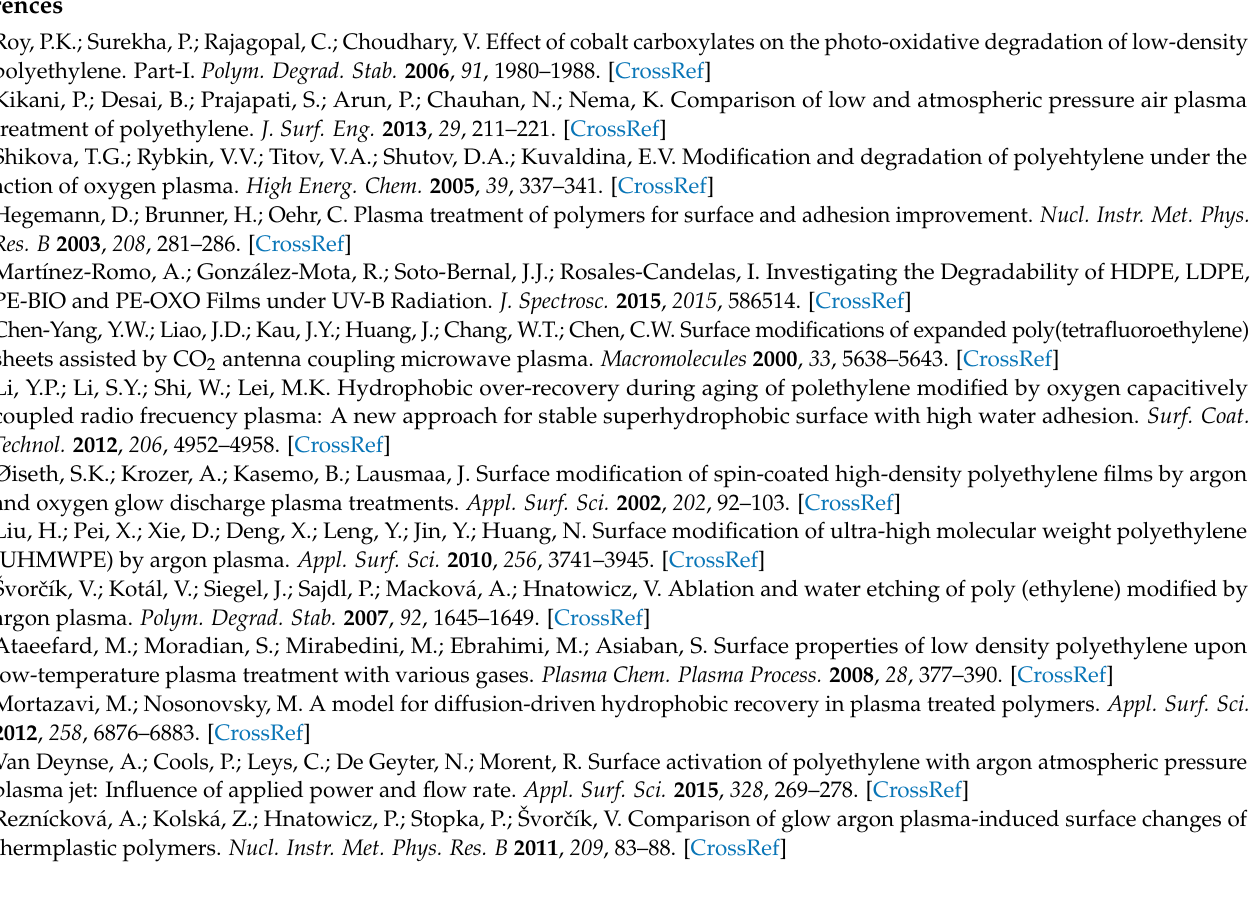
Supplementary Materials: The following are available online, Figure S1: Schematic diagram of the plasma reactor employed in this study. Figure S2: Profile of the spherical cap description for a sessile droplet. Table S1: Treatments employed for oxygen, argon, and argon-oxygen (50:50) mix. Table S2: ANOVA results for Ar, O 2 and Ar-O 2 (50:50) mix. Table S3: SCA; roughness and LDPE’s viscoelastic properties obtained during the 22-factorial design. Table S4: Response variables obtained during